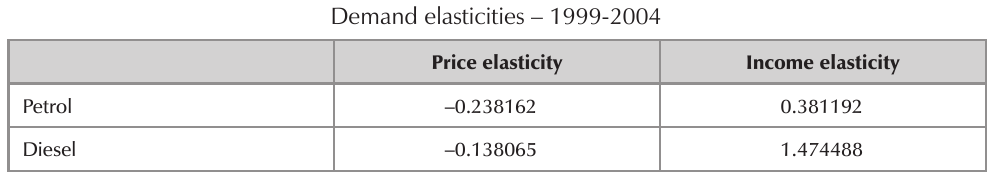
Source: Table 2.1 – Econometrix report, par.